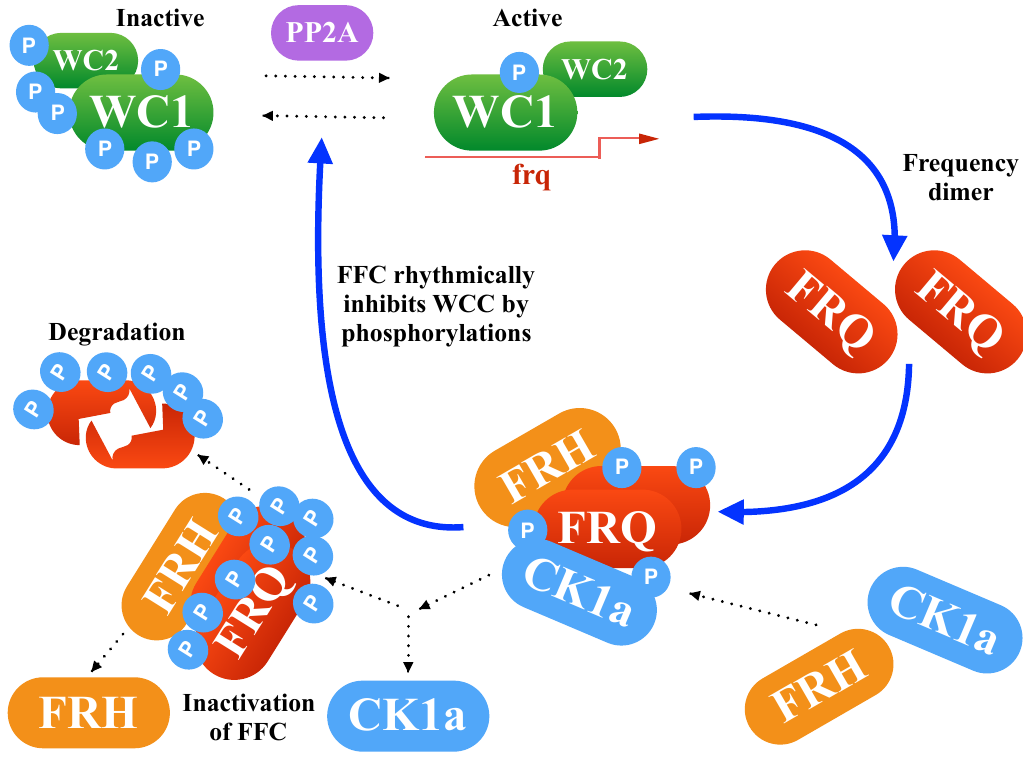
Figure 1. Core network of Neurospora ’s clock: The delayed negative feedback via FRQ is controlled by complex formations and